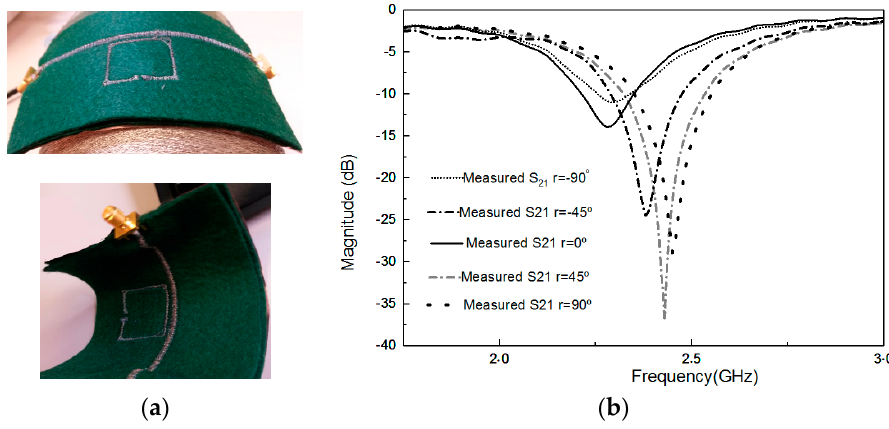
Figure 6. ( a ) Effect of bending with different curved angles. ( b ) Resonant frequency of first prototype on the felt substrate.